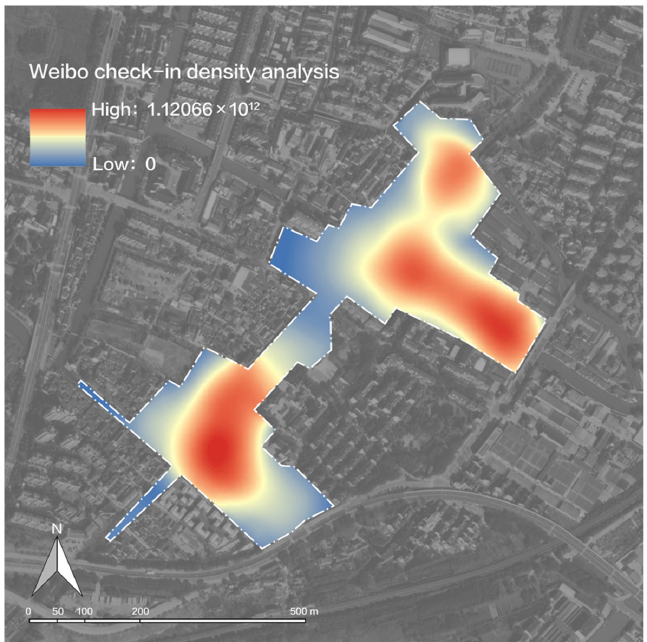
Figure 7. The Kernel density analysis of the distribution of Sina Weibo check-in data (source: authors).